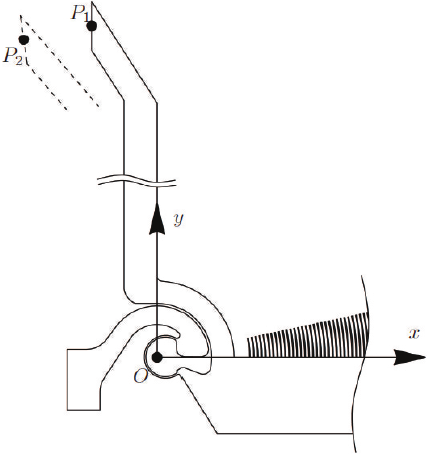
Figure 3. Von-Mises equivalent stress distribution corresponding to the applied voltage of 40 V ( a ) and flexure detail ( b ).